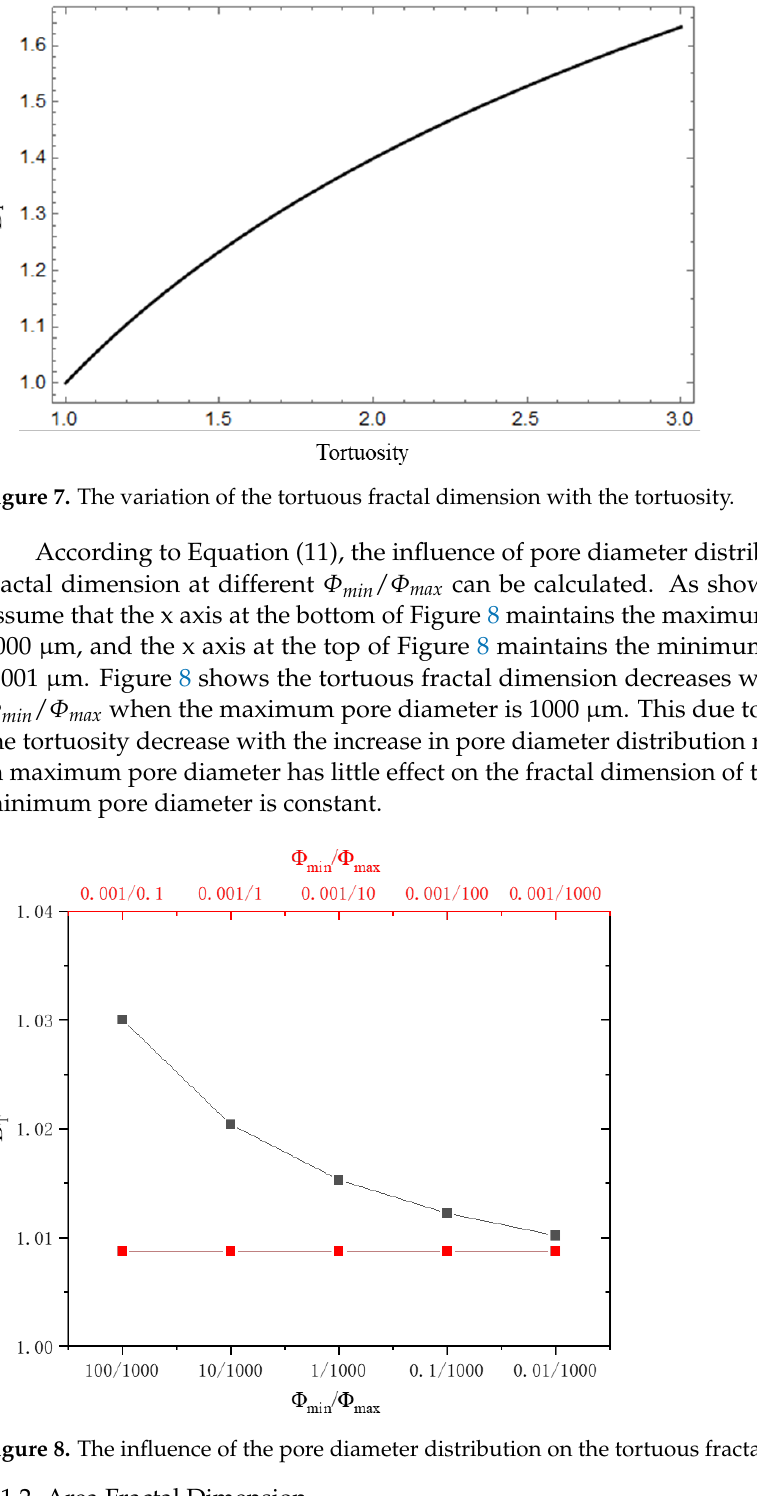
Figure 9. Effect of porosity on area fractal dimension.